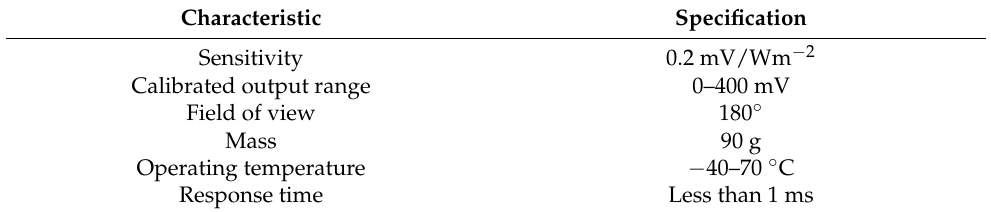
Table 2. Technical data of Apogee SP-110 pyranometer.